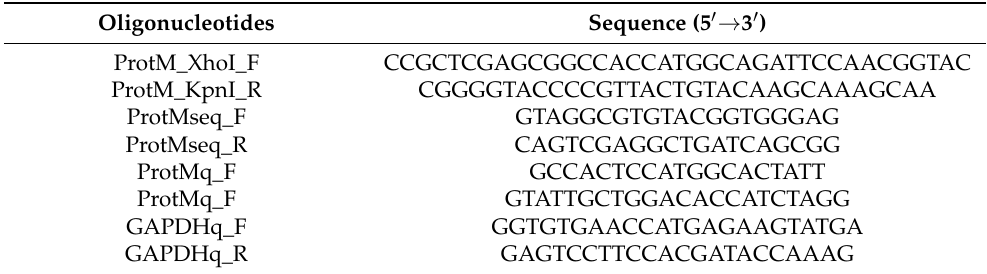
Table 2. List of oligonucleotides used in the study. Oligonucleotides Sequence (5 (cid:48) → 3 (cid:48)